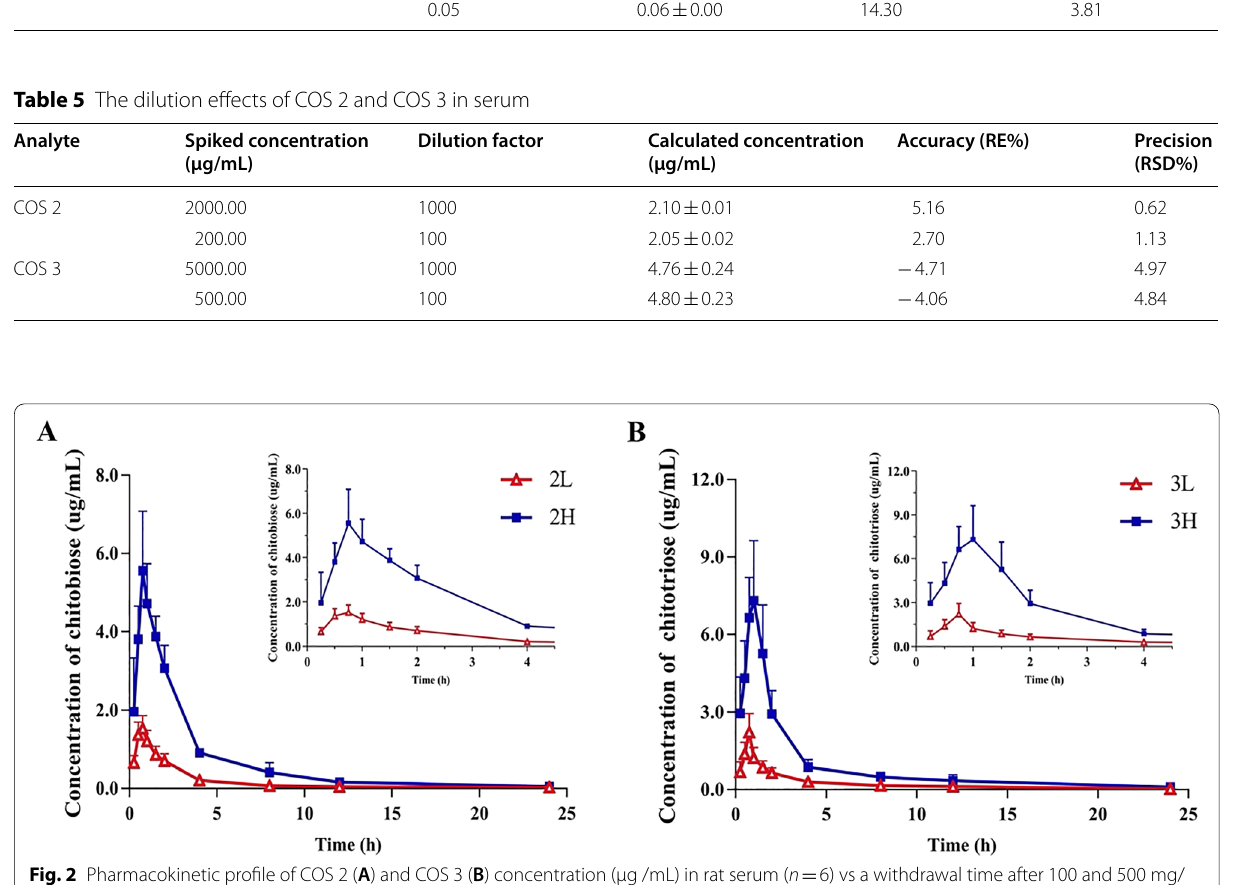
Autosampler for 24 h